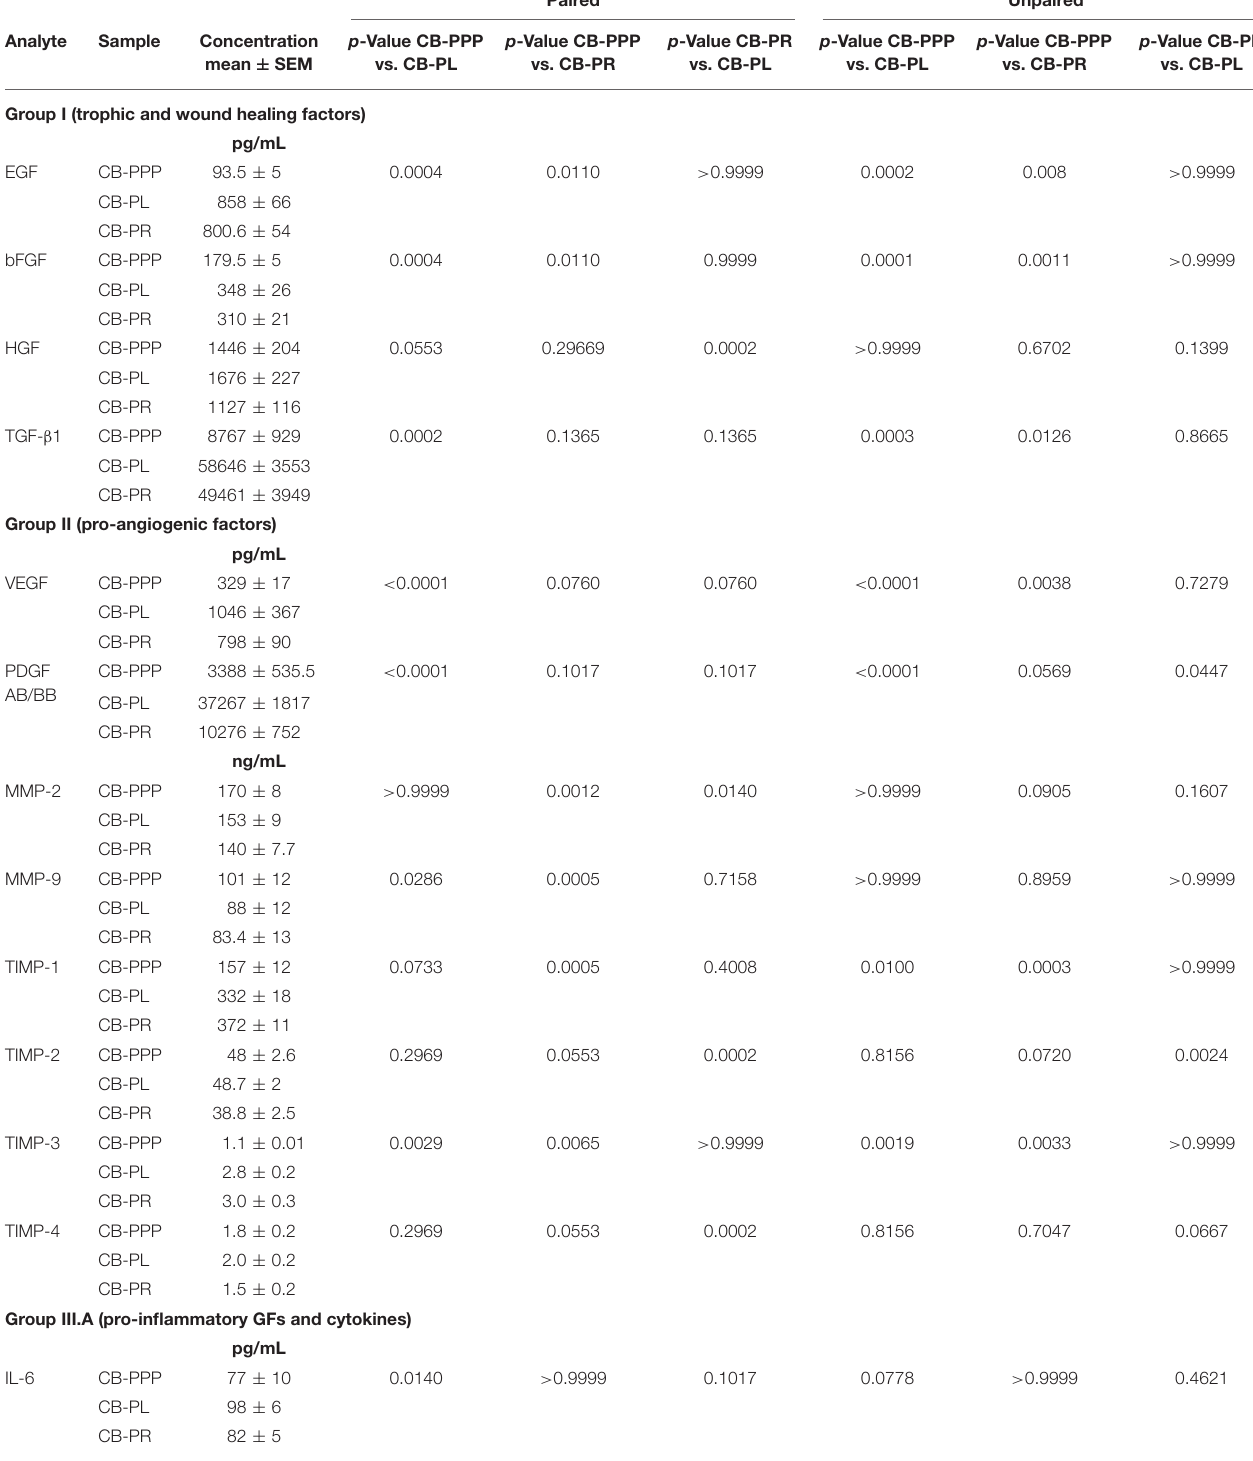
Paired Unpaired